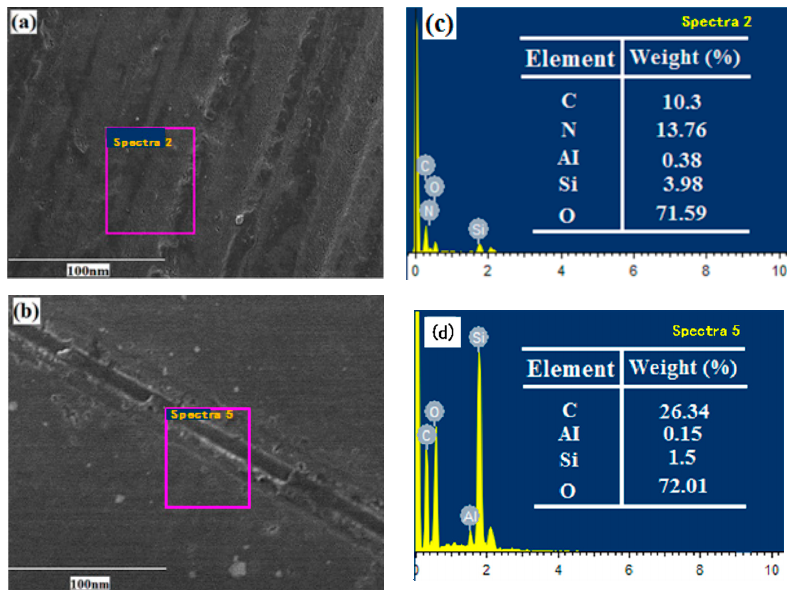
Figure 4. SEM image of worn surfaces lubricated by ( a ) pure Mdol and ( b ), Mdol containing 0.1 wt% FLG; ( c , d ) Energy-dispersive X-ray spectroscope (EDS) maps of the areas pointed out in ( a , b ).